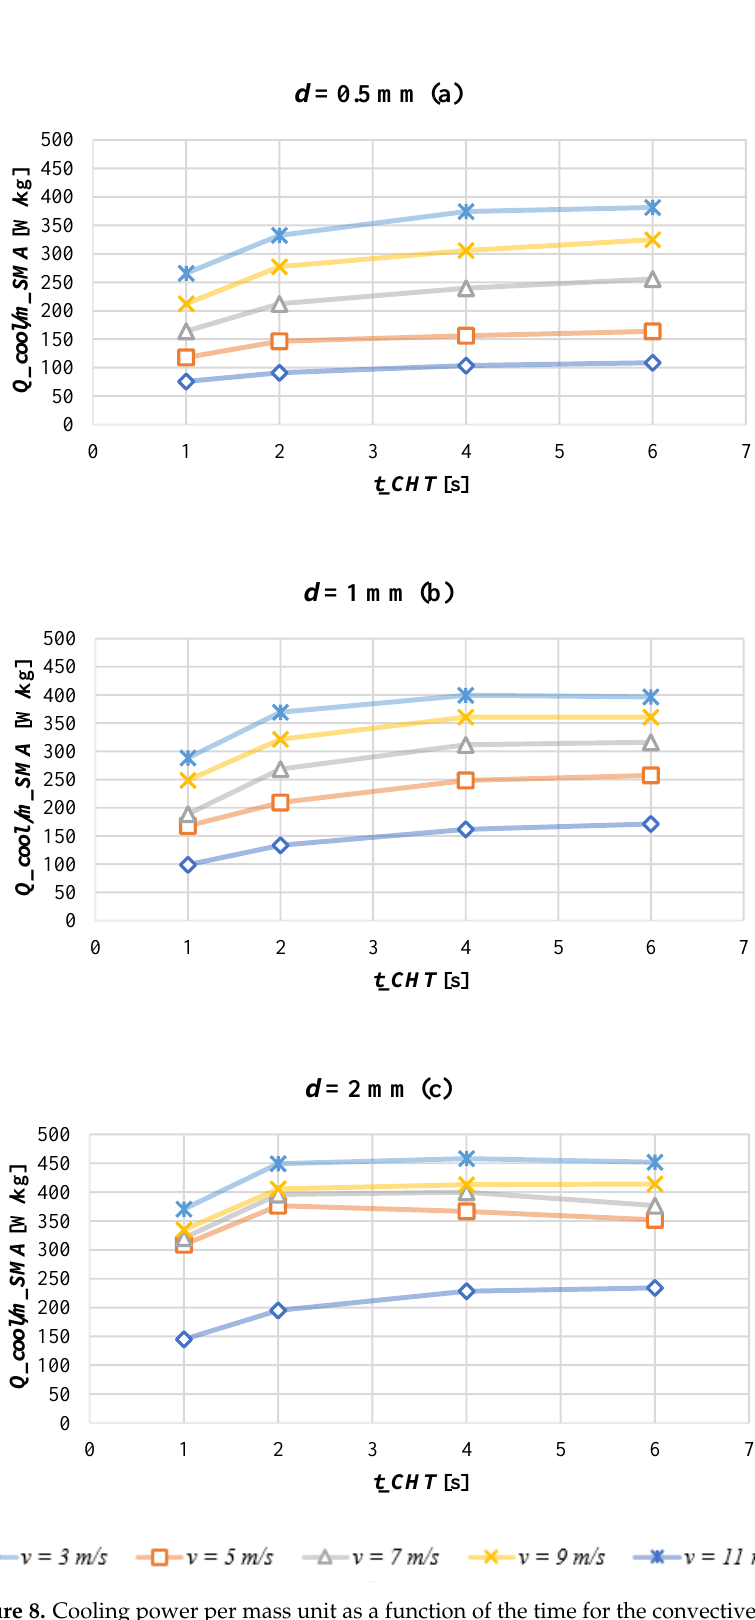
Figure 8. Cooling power per mass unit as a function of the time for the convective Heat Transfer process parametrized for fluid velocity when the distance between two wires is: ( a ) 0.5 mm; ( b ) 1.0 mm; ( c ) 2.0 mm.